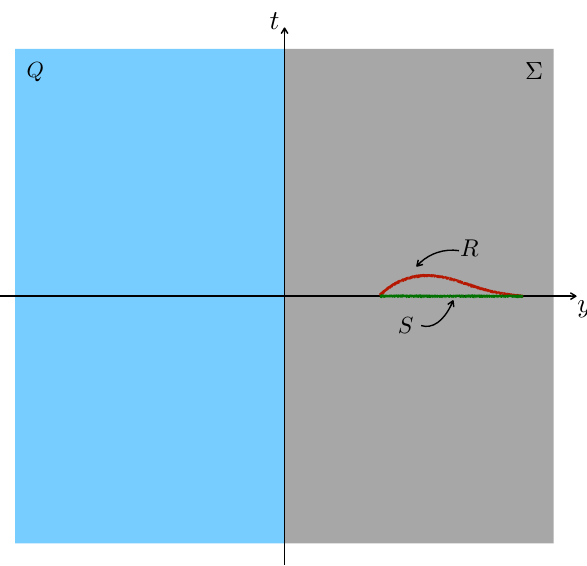
( S ) 6 = D int ( R ) . The figure shows the E E ( S ) = E ( R ) from the definition of T T ( S ) = S 6 = R = D ( R ) from the discussion in section E E